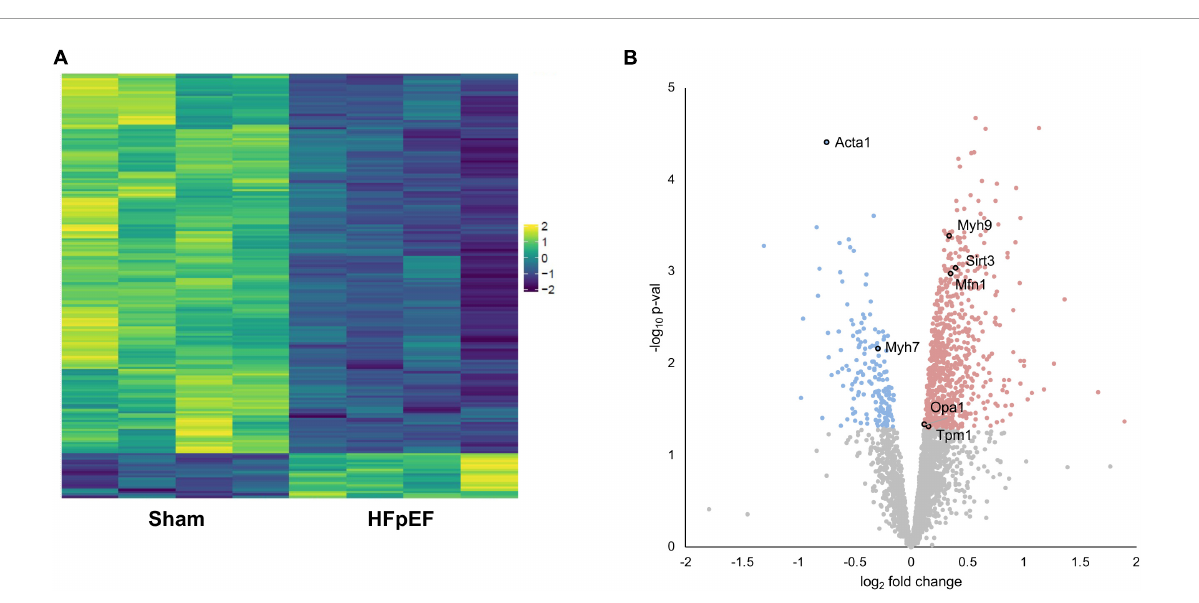
Frontiers in Cardiovascular